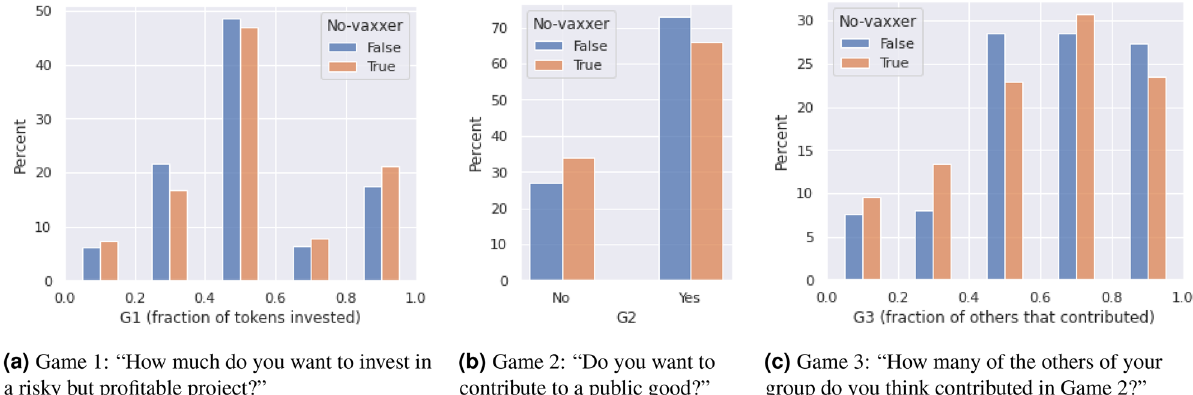
Figure 2. In panel ( a ), on the x-axis the fraction of tokens that respondents choose to invest in Game 1, with the rest of tokens not invested remaining to them. In panel ( b ), the percentage of respondents choosing to contribute to a public good in Game 2 (73% of vaxxers, 65.9% of no-vaxxers). In panel ( c ), the results of Game 3, i.e., on the x-axis respondents’ belief about the fraction of others’ contributing in Game